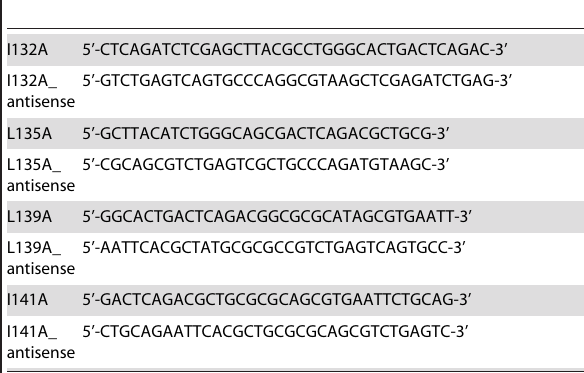
Table 2. Primer sequences used for construction of EGFP- NES2